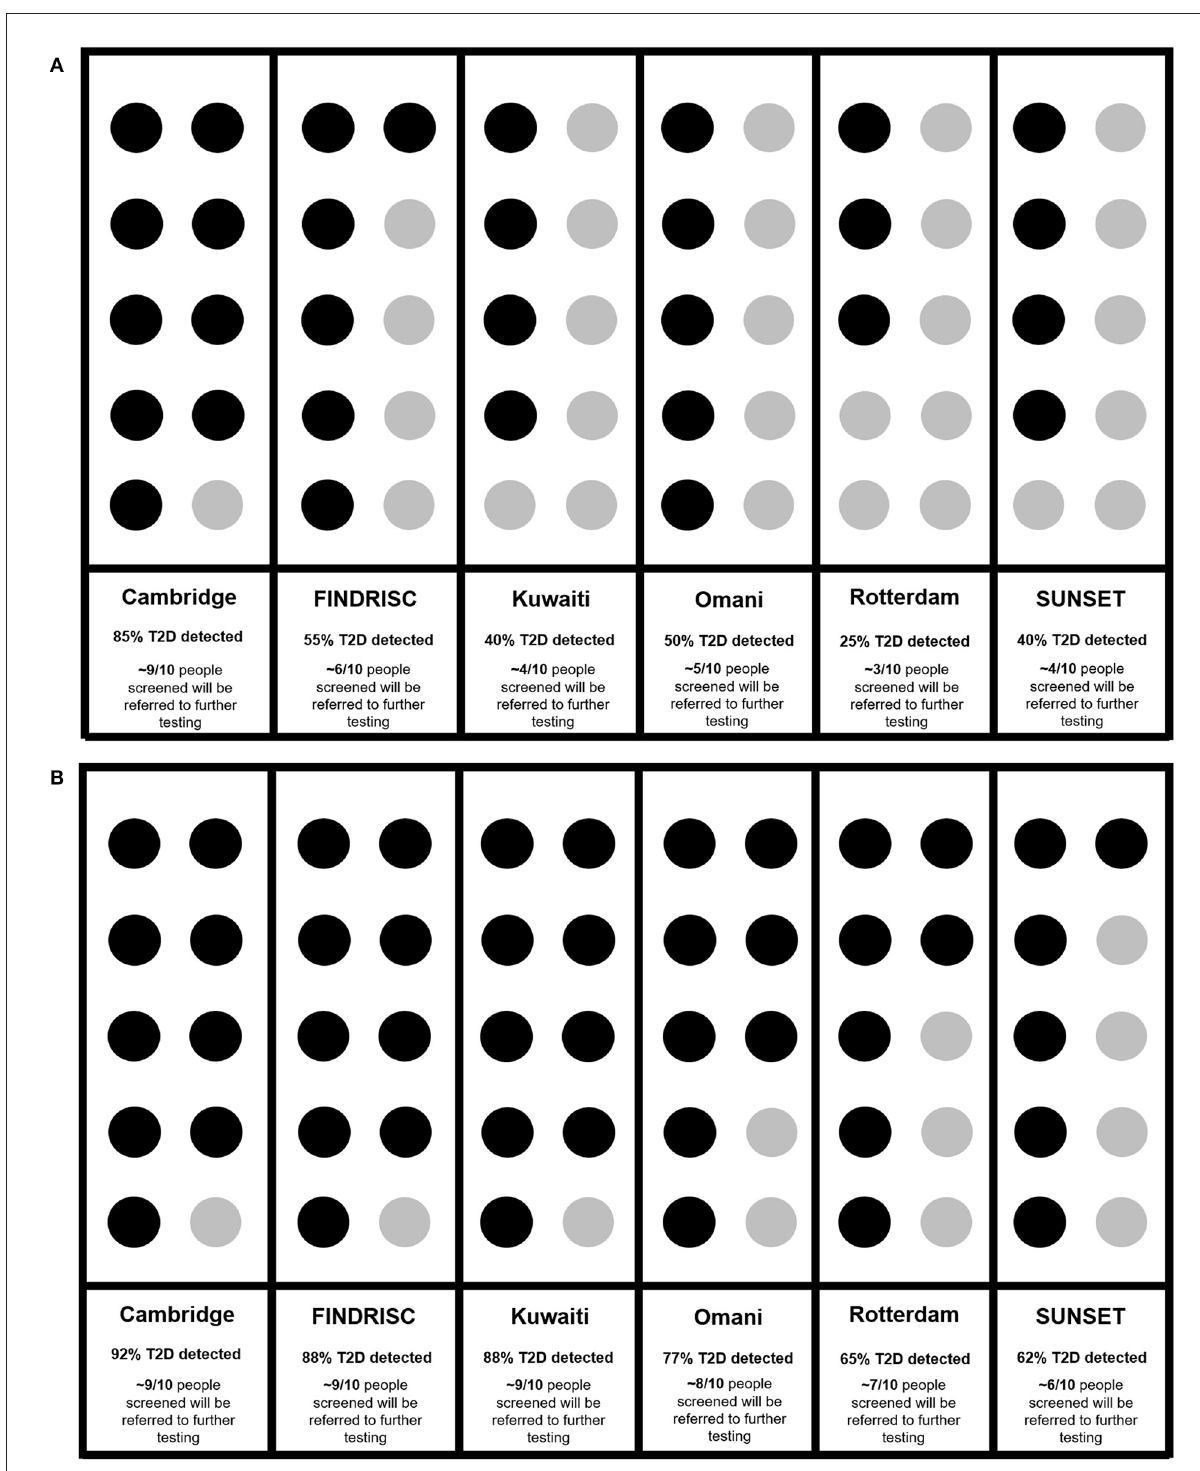
FIGURE4 (A) Ability of risk scores to identify diabetes in every 10 diabetes cases due to β -Cell-Failure. (B) Ability of risk scores to identify diabetes in every 10 diabetes cases due to insulin resistance. Cambridge (18), FINDRISC (20), Kuwaiti (21), Omani (22), Rotterdam (23), SUNSET